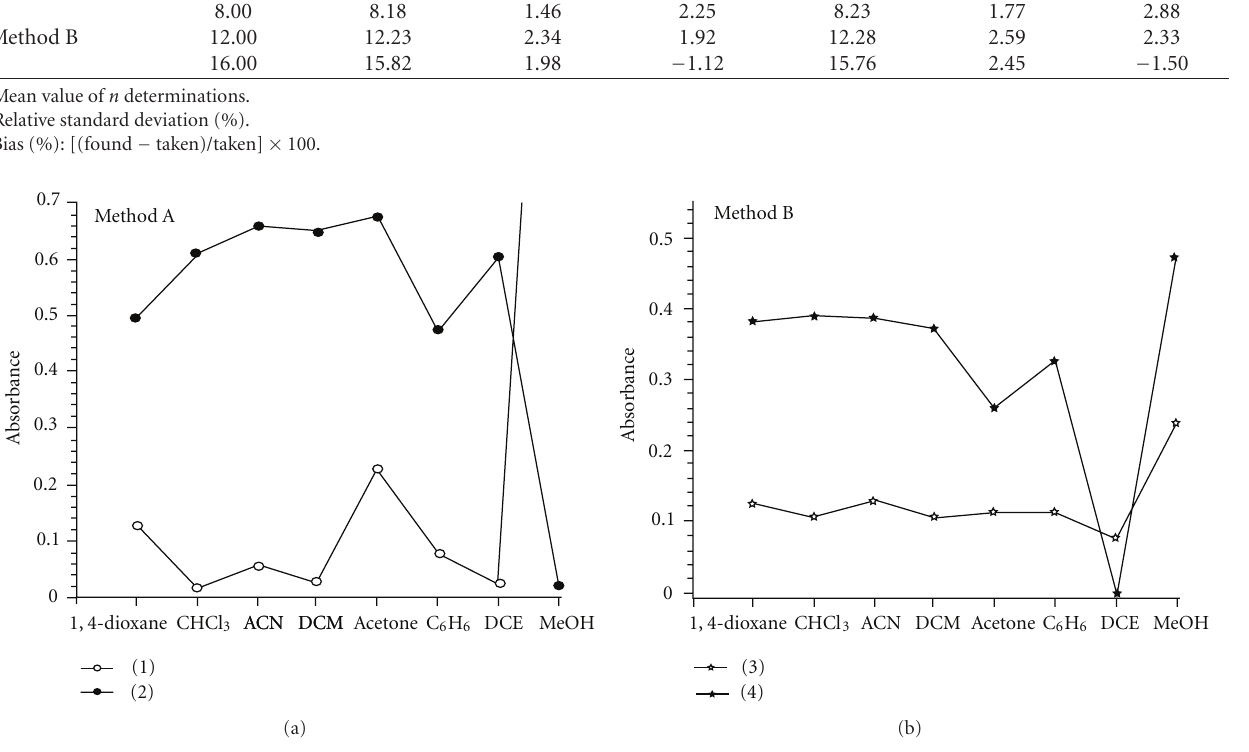
Figure 4: E ff ect of solvents on the color development: (1) corresponding blank-method A; (2) sample versus corresponding blank (7.5 μ gmL − 1 GBP)-method A; (3) corresponding blank-method B; (4) sample versus reagent blank (7.5 μ g mL − 1 GBP)-method